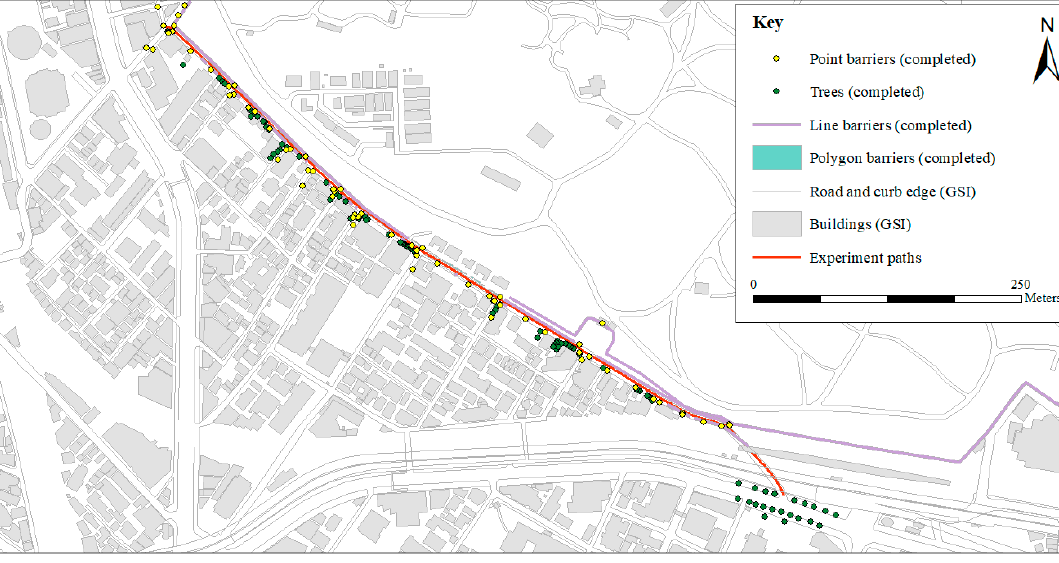
Figure 8. Map showing the completed barriers (point/line/polygon) layer, completed trees layer, GSI building footprints, GSI road and curb edge, and experiment path II.